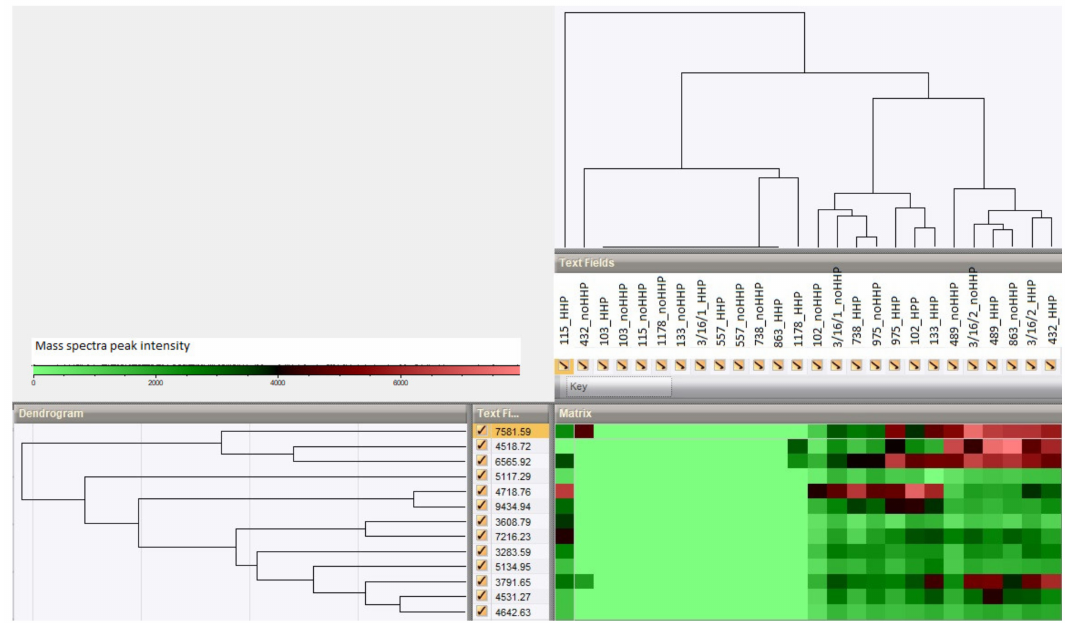
Figure 6. Two-dimensional hierarchical clustering analysis of the unpressured and pressured lactobacilli strains and the m / z values of the peak-matching mass spectra. The green indicates low peak intensity and the red indicates high peak